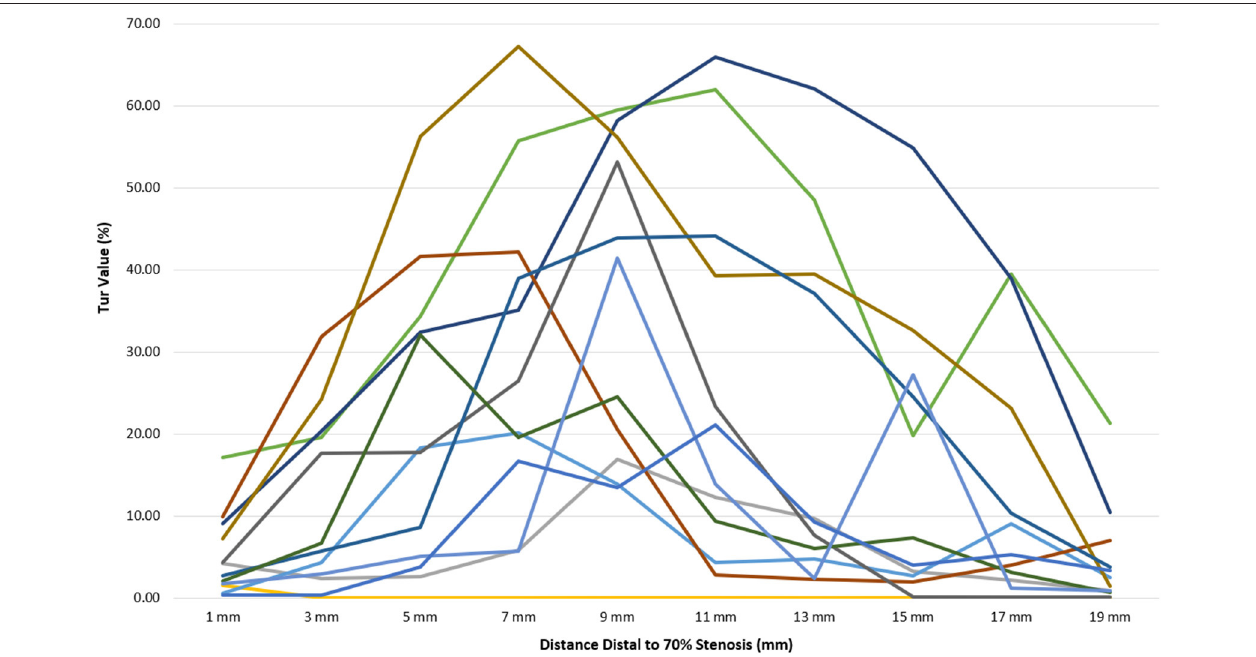
FIGURE 6 | Tur index changes in relation to distance distal to a 70% stenosis in 12 canine femoral arteries.